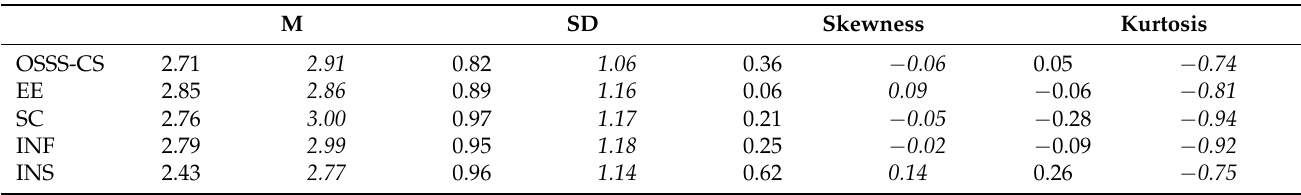
Table 2. Descriptive statistics for the OSSS-CS across the entire